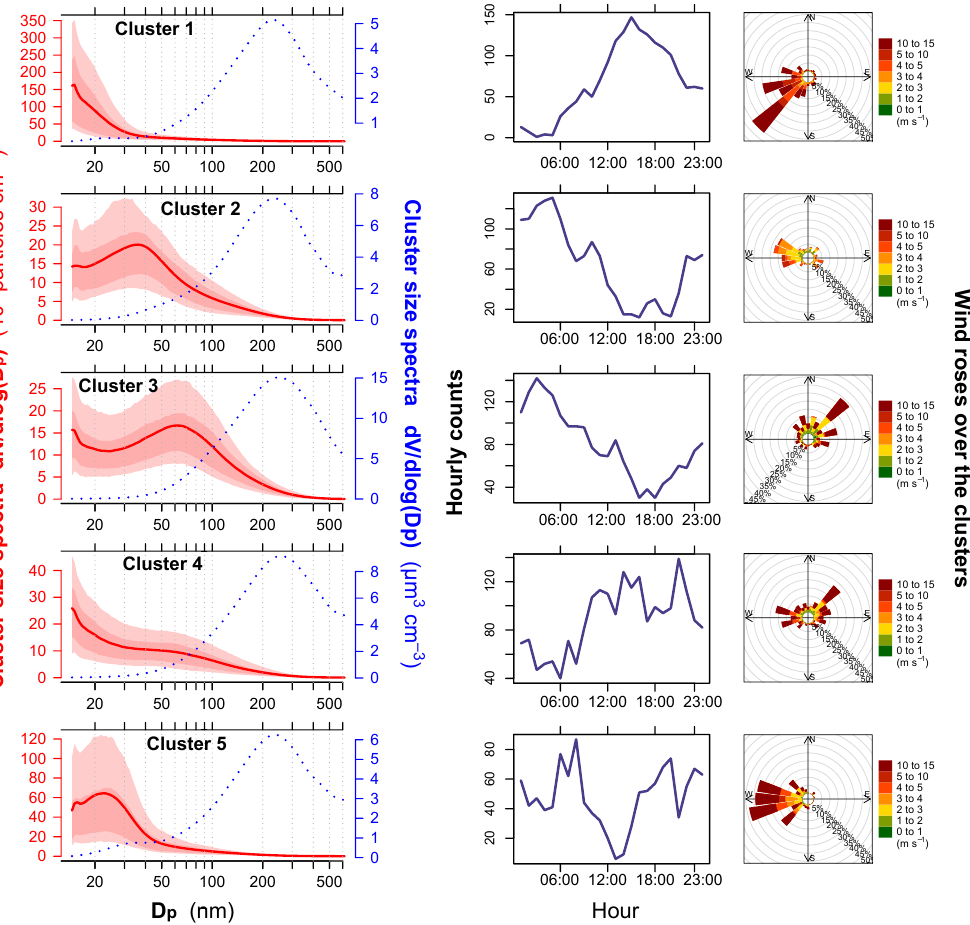
Figure 3. Results of cluster analysis for the warm season data. Average cluster PNSD spectra (left) are reported as solid red lines along with (i) their 10th, 25th, 75th and 90th percentile spectrum as shaded areas, (ii) the volume size distributions (dotted blue line), (iii) the hourly counts, and (iv) the wind roses associated with each